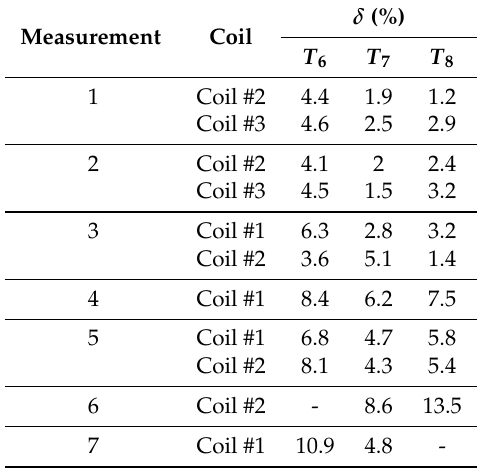
Table 3. Average relative deviation of SIMT for operating measurements.